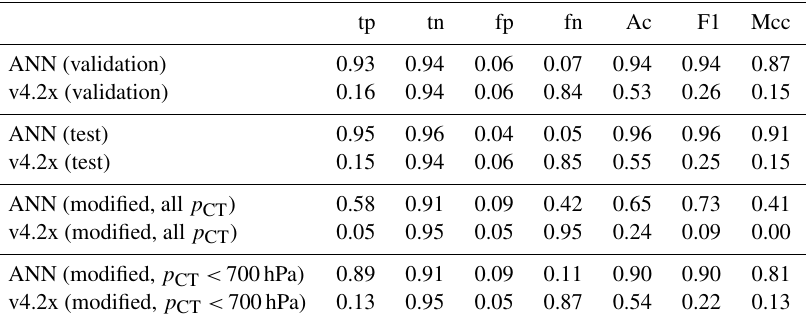
Table 2. Binary classification statistics for the new ANN algorithm, as well as the classification provided by the current MLS v4.2x status flag. Prescribed labels (i.e., clear sky or cloudy) are provided by the standard definitions presented in Sect. 3.2; statistics are given for both the validation and test data sets. Results for two modified definitions based on looser thresholds are also given; here statistics are based on all profiles in the MLS–MODIS data set (minus the training data). The fraction of true positives and negatives (tp and tn), as well as false positives and negatives (fp and fn), is given. Finally, three measures for the evaluation of binary statistics are listed: the accuracy (Ac), the F1 score (F1), and the Matthews correlation coefficient